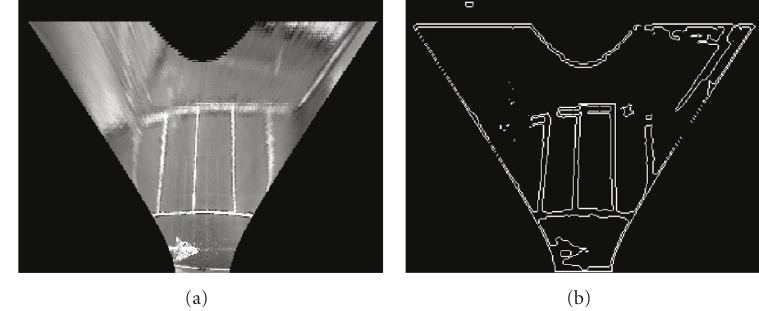
to a straight line whose prolongation will pass the vertical projection point of the camera on the world surface. Second, a horizontal straight line in the image will be projected to a straight line instead of an arc on the world